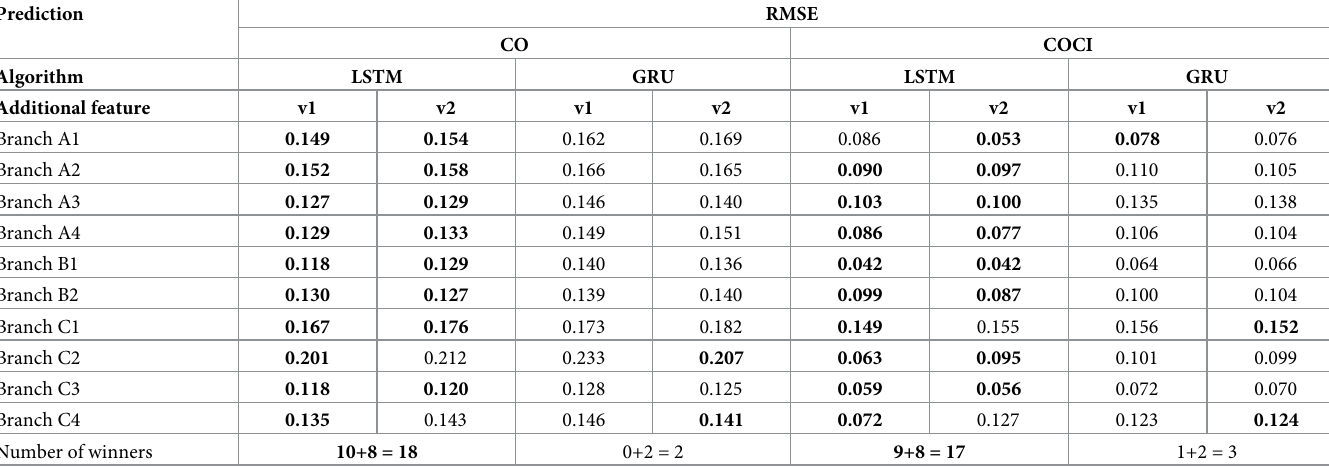
Table 6. LSTM and GRU comparison based on RMSE values of different branches in the 30-day period.